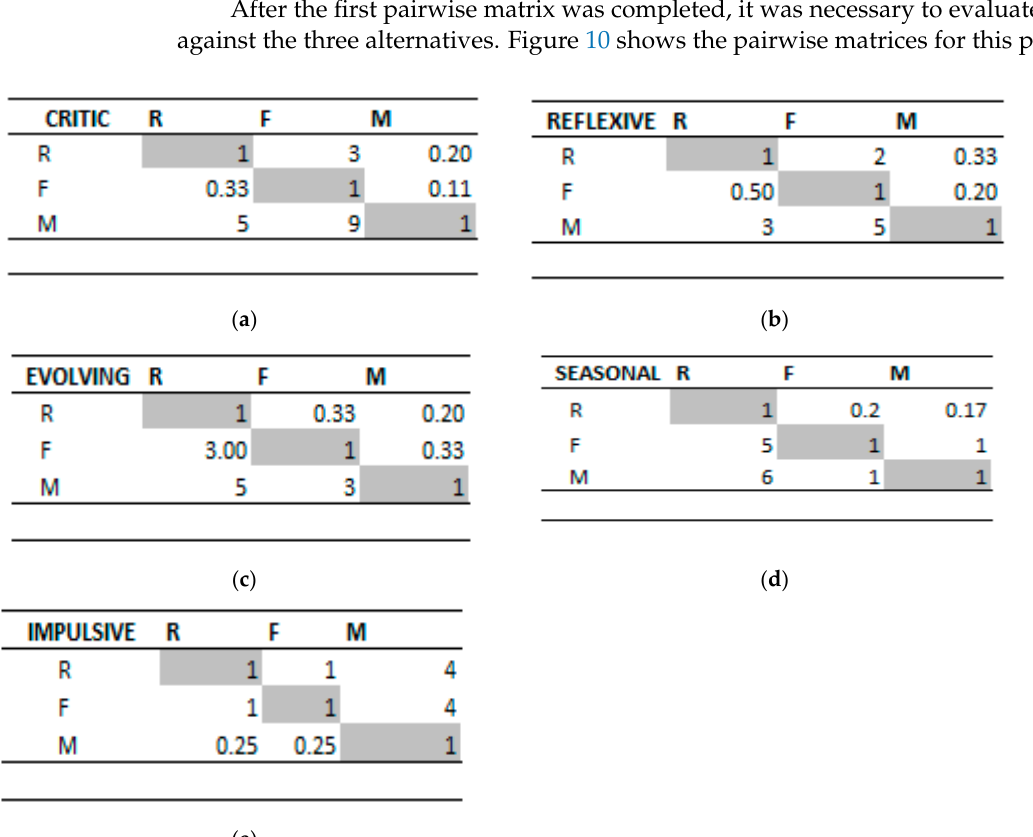
Figure 10. Pairwise matrices for each criterion vs. each alternative: ( a ) comparisons of R, F and M regarding critic products , and we can observe how for critic products , M >R > F; ( b ) comparisons of reflexive products , and here, M > R > F; ( c ) comparisons of evolving products , where experts said that M > F > R; ( d ) in seasonal products M ≥ F > R; and ( e ) impulsive products with F = R > M.